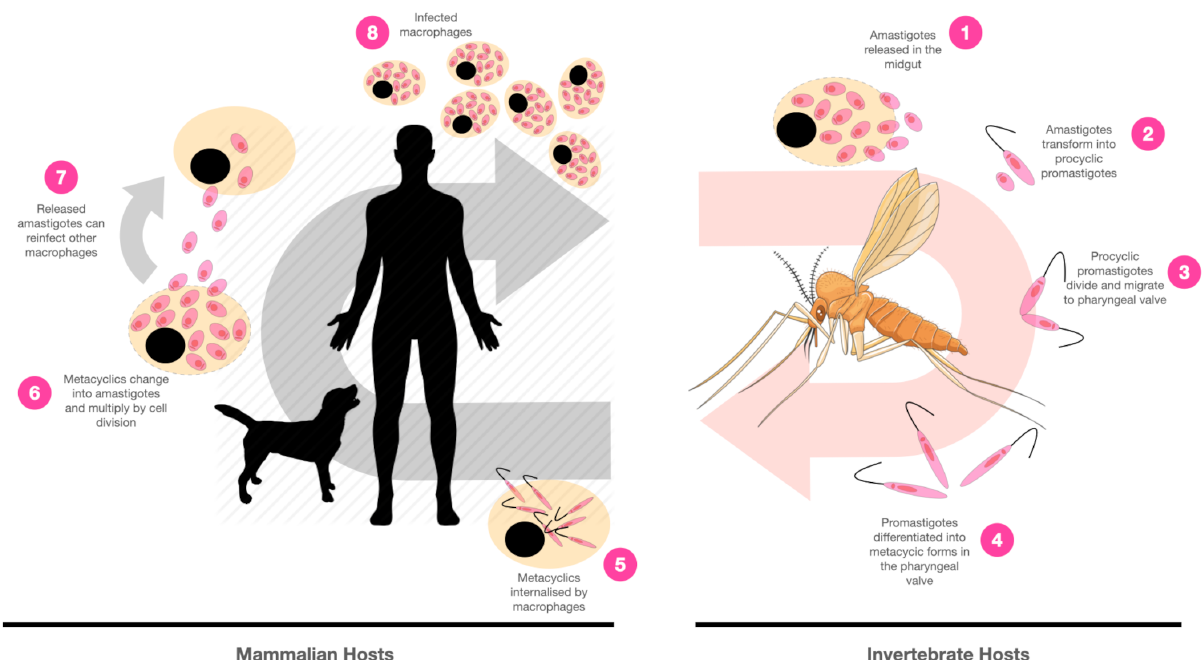
Figure 1. Schematic illustration of the Leishmania spp. infective cycle showing different parasite stages of development. Phlebotomine female sandflies get infected with amastigote forms during bloodmeals (1). Amastigotes transform into procyclic promastigotes, which will proliferate inside the invertebrate midgut (2 and 3). Promastigotes then migrate to the sandflies’ pharyngeal valve (4) and differentiate into metacyclic forms. The metacyclic forms are transferred to the mammalian hosts’ bloodstream during a new blood meal and infect macrophages and other cells from the mononuclear phagocyte system (5). Inside the macrophages, there is a metacyclic change into amastigote forms, which multiply, lyse the macrophage, and reinfect new macrophages (6 and 7). In a new cycle of infection, the infected macrophages are ingested by new phlebotomines (8). The silhouettes of man and dog and the sandfly clipart are free for use and were withdrawn from the websites HiClipart (https://www.hiclipart.com, accessed on 8 November 2021) and Gratispng (https://www.gratispng.com, accessed on 8 November 2021),